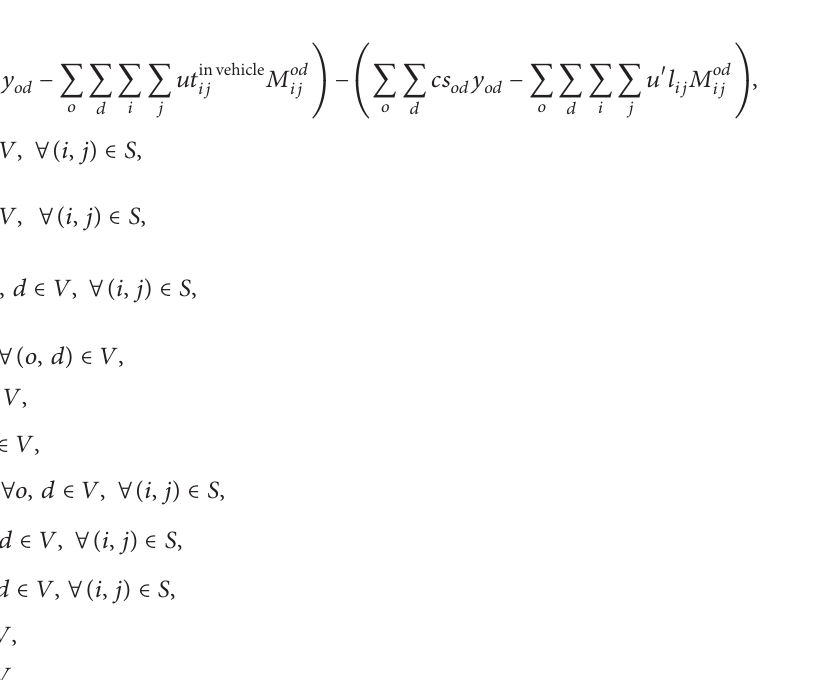
Figure 5: Overall solution